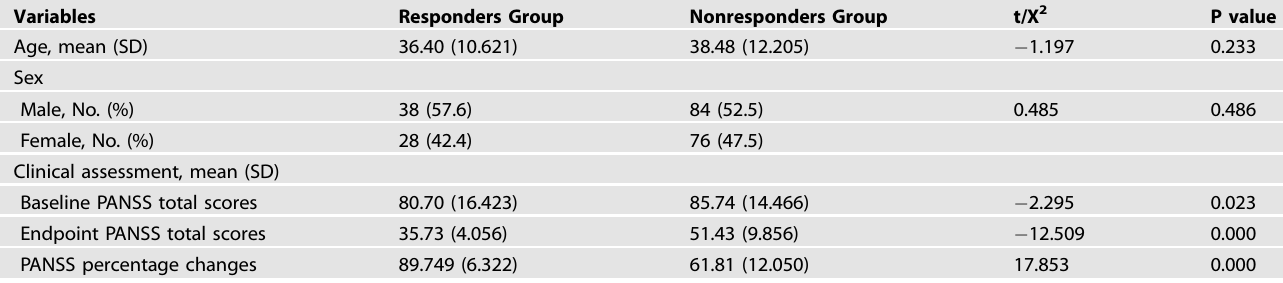
Table 1. Demographic and clinical characteristics of samples.